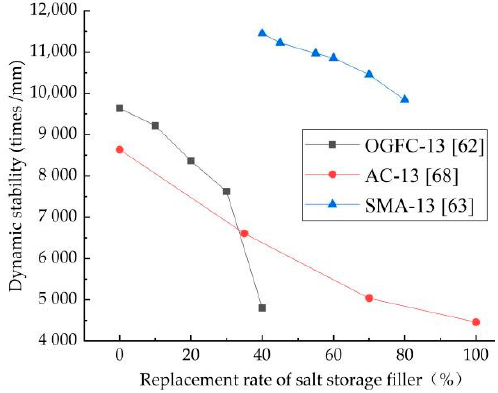
Figure 5. Rutting test of the different types of salt-storage mixtures. (Peng, et al. 2015 [62], Liu, et al 2016 [63], Zhang, et al 2011 [68])